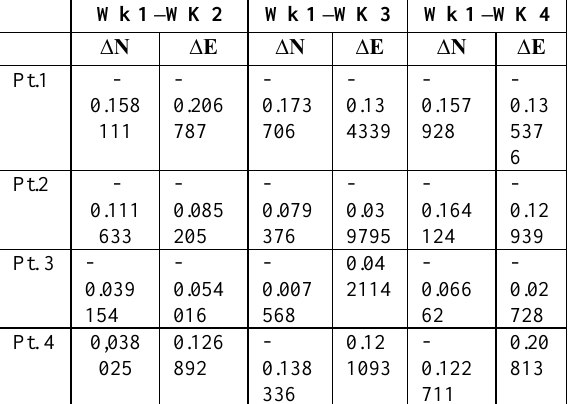
Figure 10. Geographical Coordinates of all four Weekly Surveys in CloudCompare